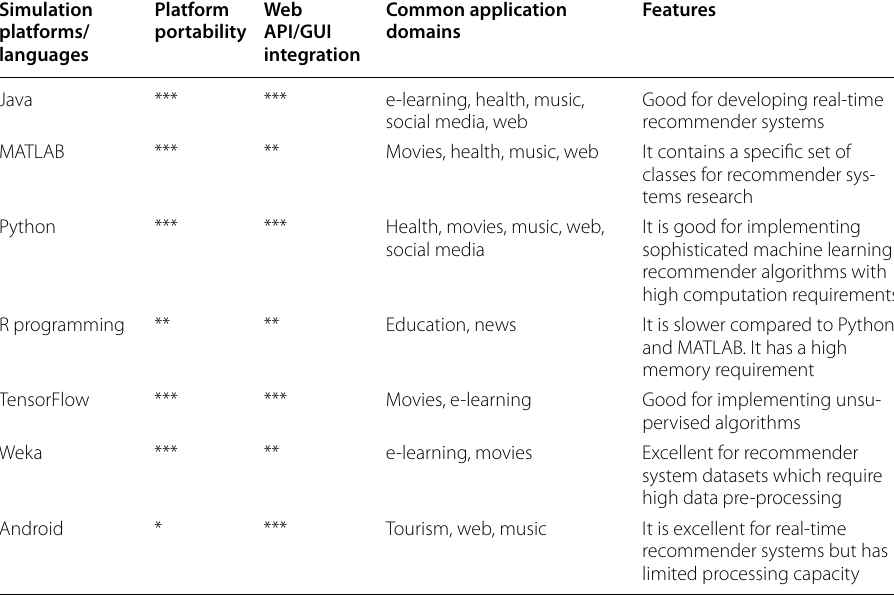
Table 7 Common simulation platforms and their related